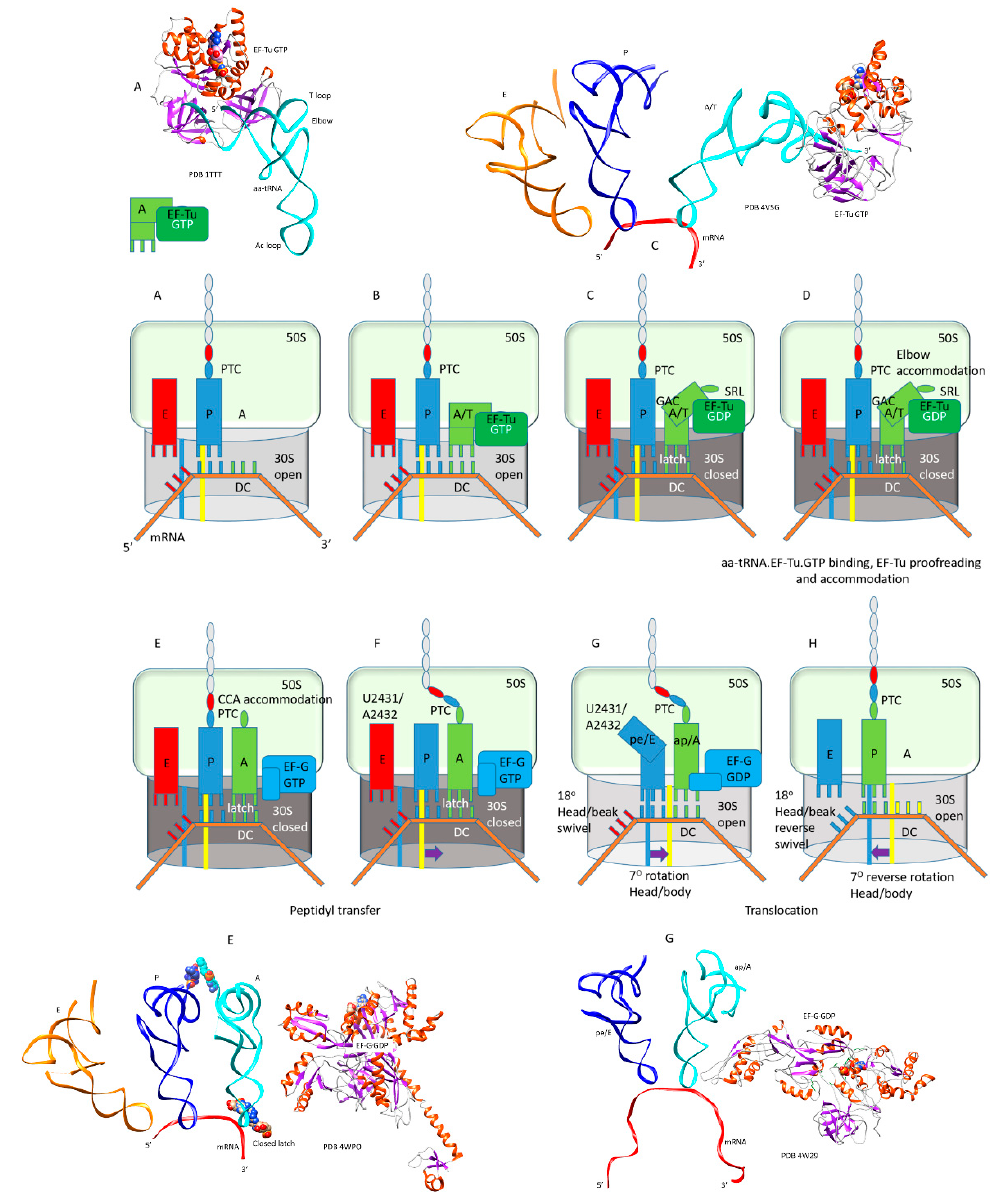
Figure 3. Stages of the translation elongation cycle; ( A , B ) binding of the aa-tRNA · EF-Tu · GTP ternary complex to the A/T site; ( C ) conformational closing of the 30S subunit and forming the codon-anticodon A-site latch; ( D ) elbow accommodation of aa-tRNA; ( E ) full CCA accommodation of aa-tRNA to the A/A-site, release of EF-Tu · GDP, entry of EF-G · GTP; ( F ) peptidyl transfer; ( G ) EF-G · GTP → GDP and onset of translocation, opening of the codon-anticodon latch, formation of hybrid tRNA states pe/E and ap/A or ap/ap; ( H ) full forward and reverse translocation. Some intermediate x-ray or cryo-electron microscopy structures are shown.